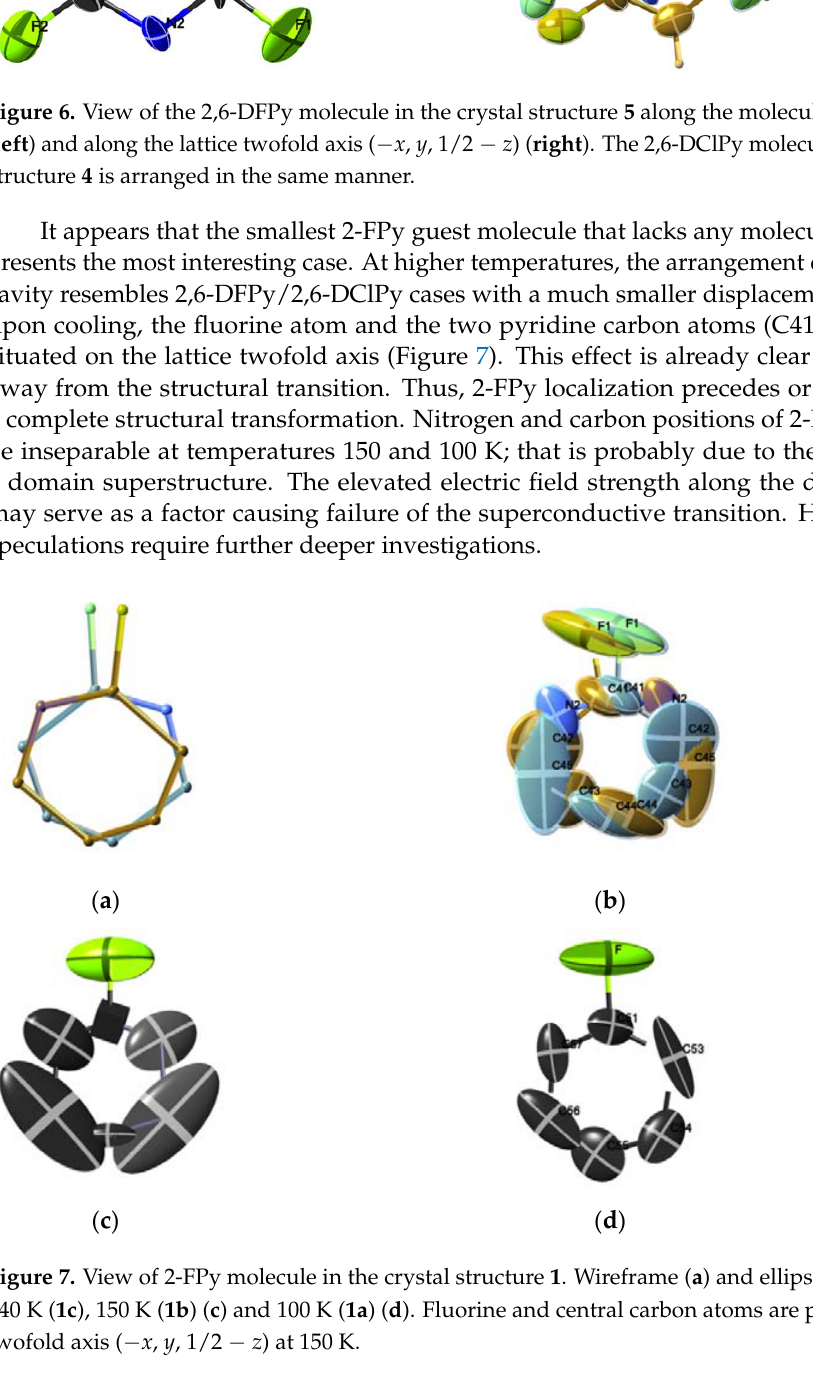
Figure 8. Anion layer of salt 3 . 2.3. С onducting Properties The temperature dependences of the out-of-plane resistivity for the samples 1 – 5 are presented in Figure 9. All these samples are metals despite the existence of the negative slopes on the low-temperature parts on the ρ ⊥ (T) curves for the samples 5 and 1 . Moreover, the sample 5 demonstrates a sharp resistance drop at low temperature which one can surely attribute to the onset of a superconducting transition at T c = 3.1 K. Unfortunately, we could not reach the real zero resistance state, even at our minimal temperature 1.4 K, because the superconducting transition is not very narrow. This is